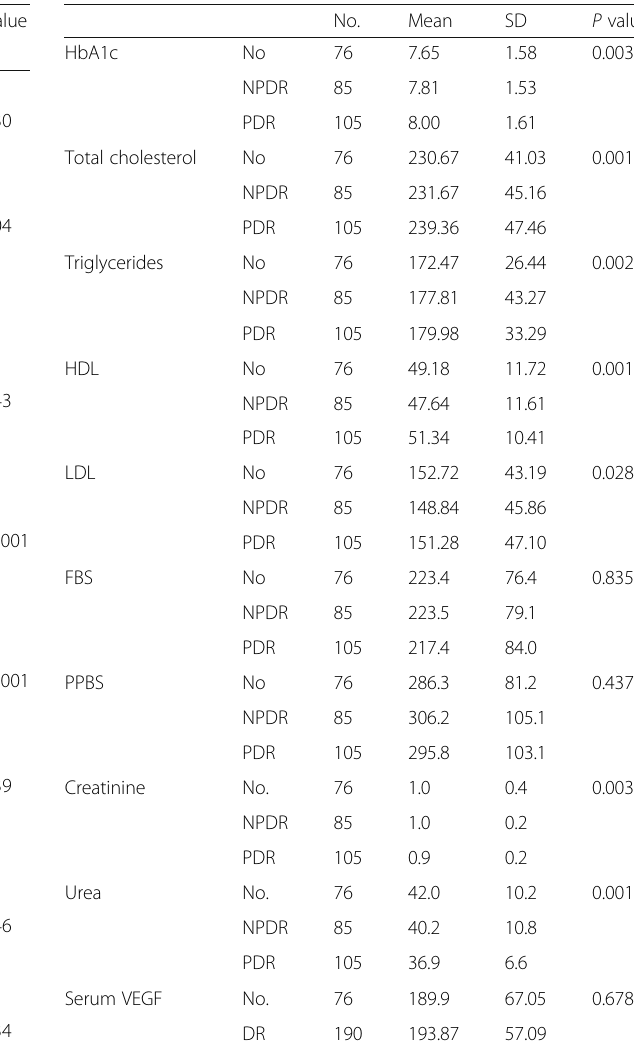
Table 3 Laboratory investigations of diabetics grouped according to DR